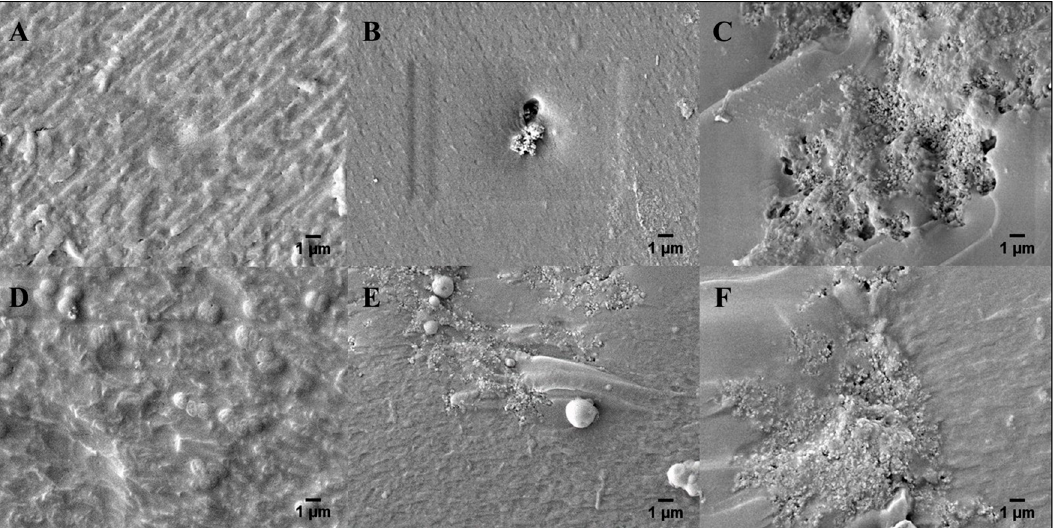
Figure 7. SEM images of freeze-fractured surfaces of microlithographically produced hydrogels with ( A ) 0.00, ( B ) 0.10, and ( C ) 1.00 wt% PAn-PAAMPSA. 3-D printed hydrogels with ( D ) 0.00, ( E ) 0.10, and ( F ) 1.00 wt% PAn-PAAMPSA (magnification: ×5000).